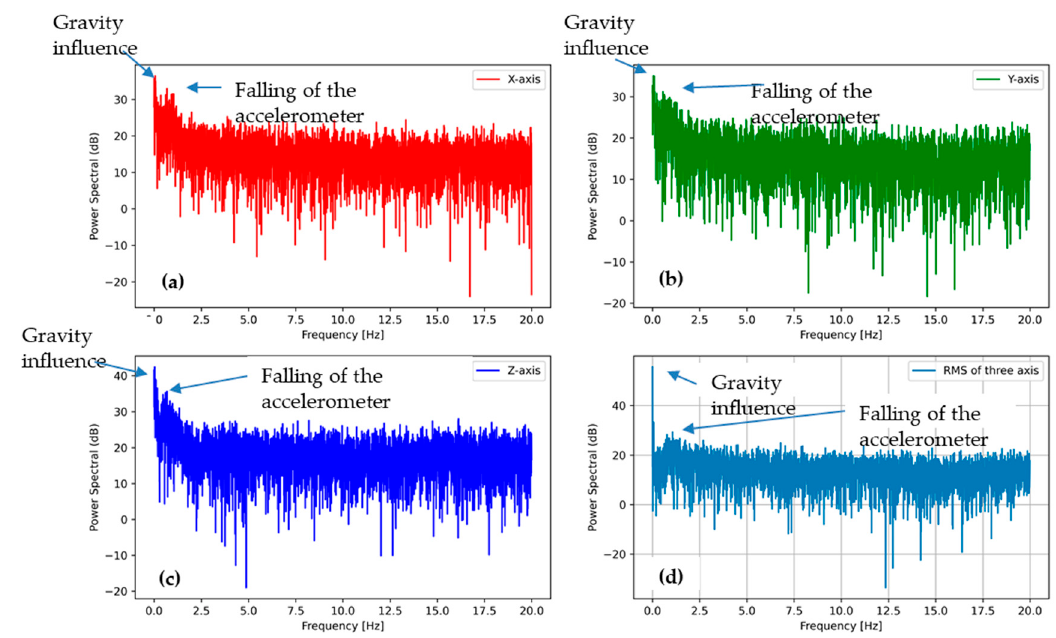
Figure 10. Power spectral density (PSD) of the accelerometer outputs of washing phase (low-speed rotation action) ( a ) in the X direction, ( b ) the Y direction, and ( c ) the Z direction, as well as ( d ) the sum of all the accelerations.